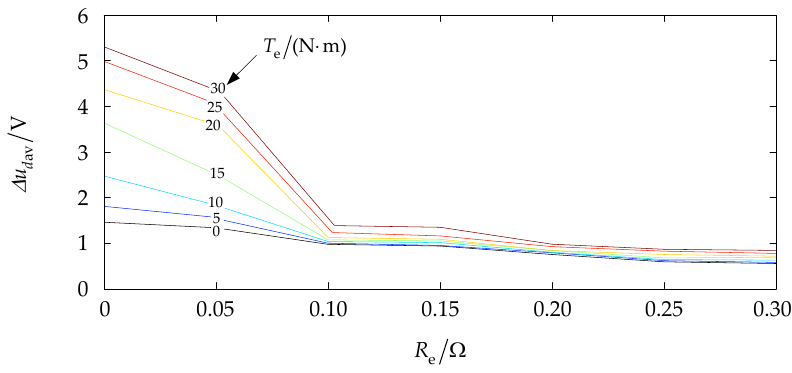
Figure 26. The variation curves of ∆ u d av with the electromagnetic torque and the external contact resistance.